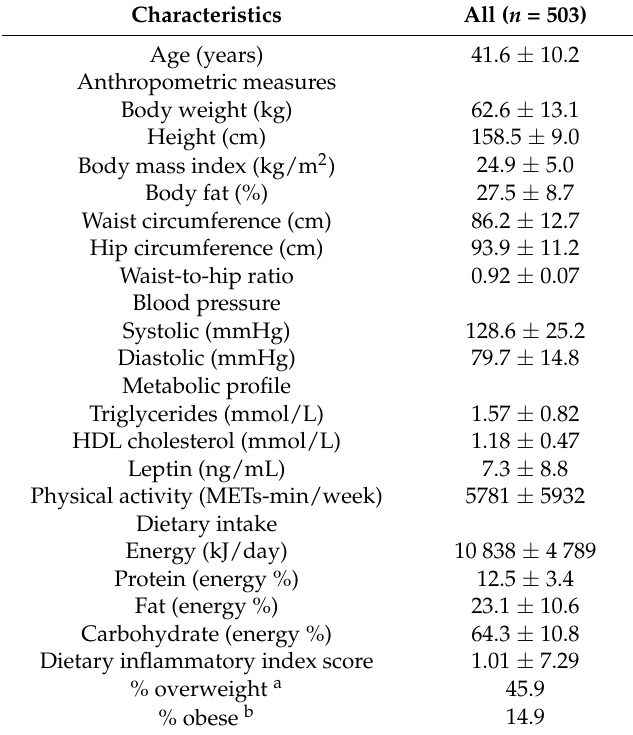
Table 1. Characteristics of study